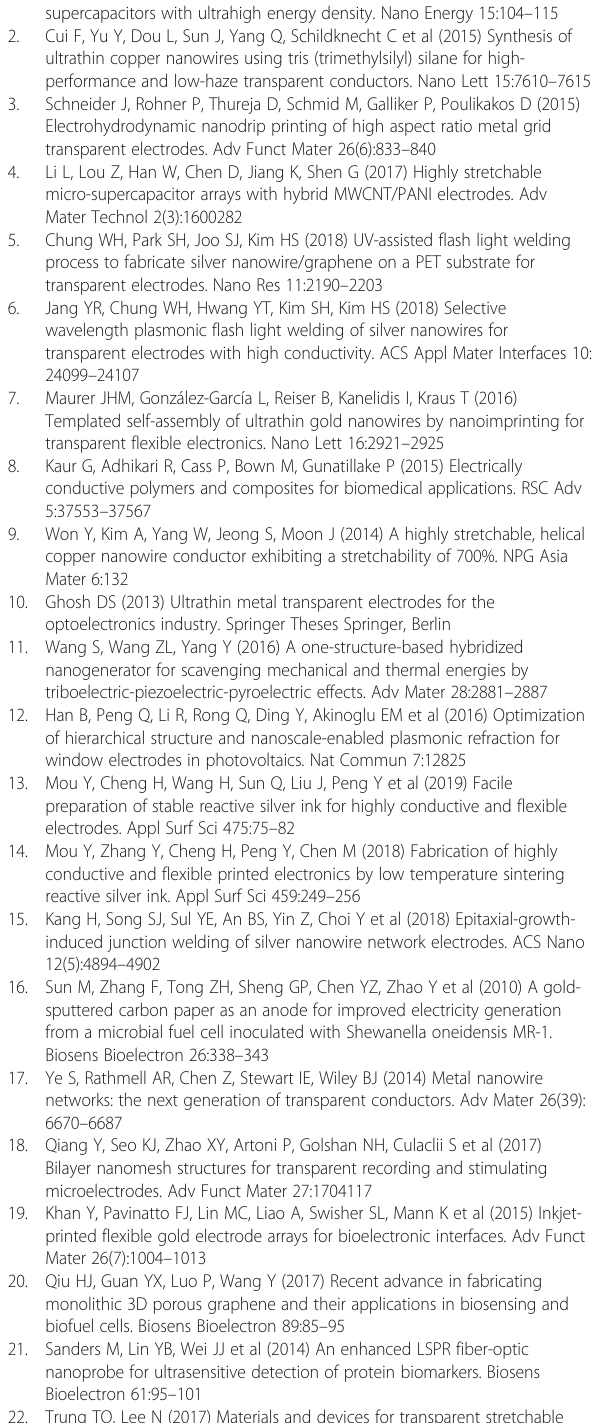
Additional file 1: Figure S1. Schematic diagram of the simulated unit cell of AuNM on PET. (a) Top view. (b) Perspective view. Figure S2. Schematic diagram of the simulated models. (a) AuNM. (b) AuNM on PET. Figure S3. The potential distribution map of AuNM at constant current. Figure S4. The stress distribution map of the AuNM electrodes during bending simulation under 1.5 × 10 9 N/m 2 force at the Y direction. (DOC 1287